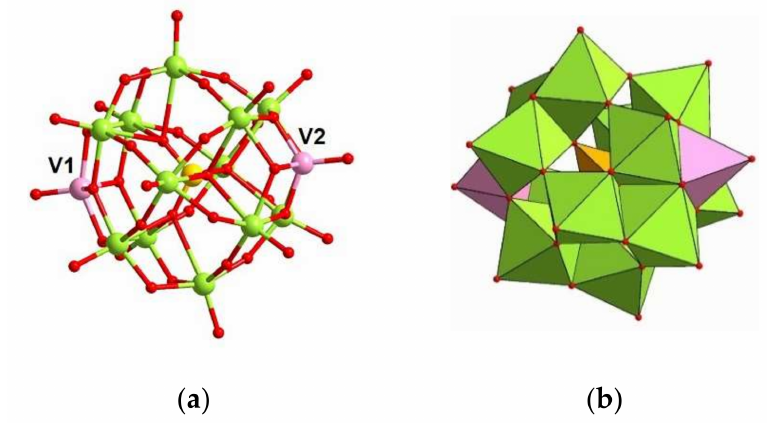
Figure 2. Crystal structure of polyanion in 2 . ( a ) Ball-and-stick representation of {PNb 12 O 40 (VO) 2 } in 2 . ( b ) Polyhedral representation of {PNb 12 O 40 (VO) 2 } in 2 . Color codes: Nb, green; V, pink; P, yellow; O,